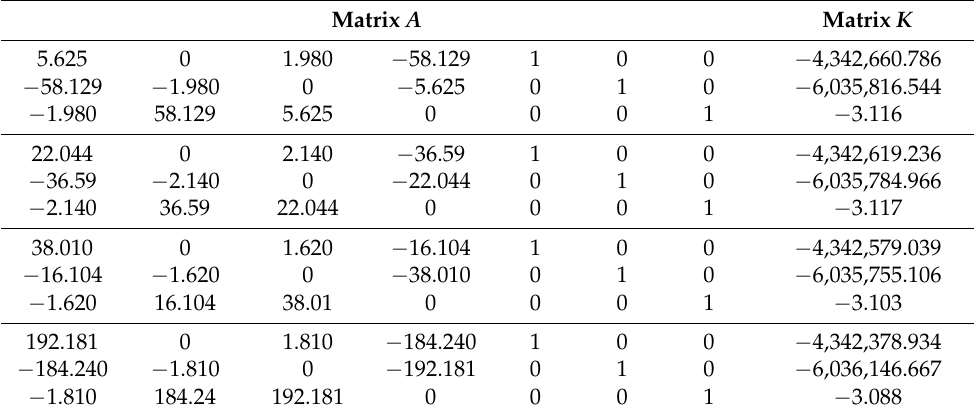
Table 8. Correction equation coefficient matrices and constant term. Matrix A Matrix